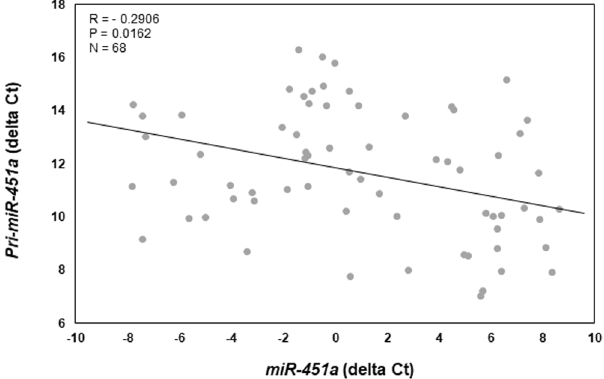
Figure 4. Correlation between mature miR-451a and pri- miR-451a in individual endometriotic lesions. Delta ct values (mature miR-451a or pri- miR-451a – U58) were plotted and Spearman’s correlation coefficient was calculated. There was a significant negative correlation in lesion expression between mature- and pri- miR-451a .